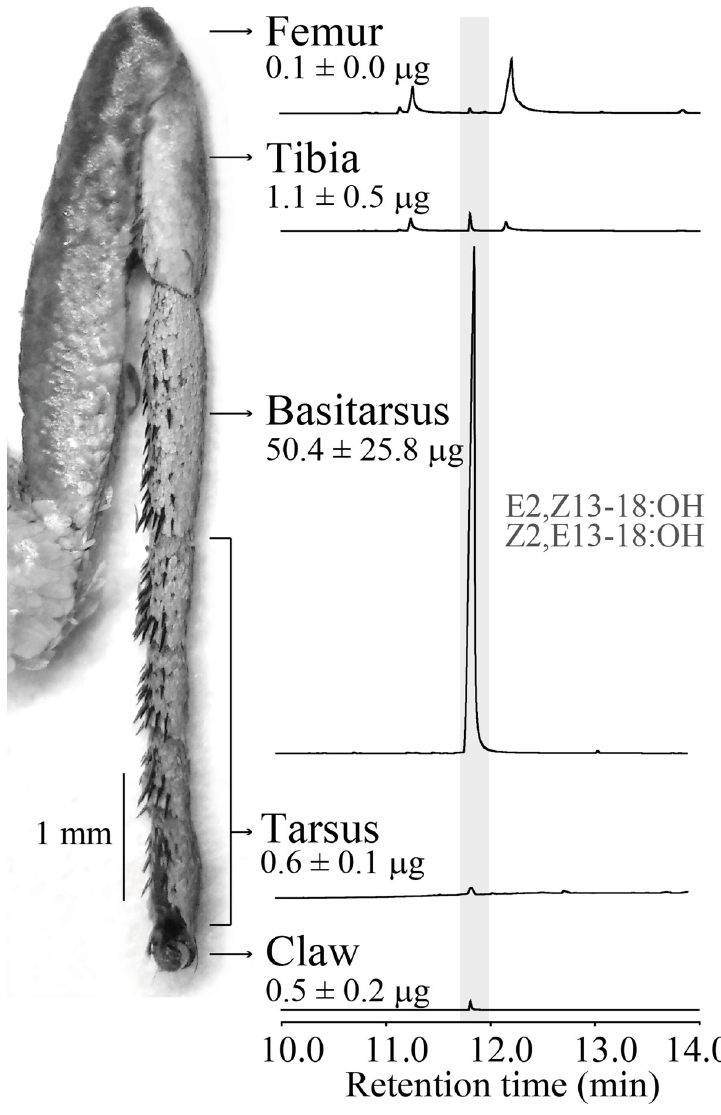
Fig 4. Chromatogram of midleg segments of male Telchin licus . Chromatogram showing the presence of Z2,E13-18: OH and E2,Z13-18:OH (highlighted) and the amount of the diastereoisomer mixture in each midleg segment per male (means ± SEMs). GC-FID equipped with an Rtx-5 capillary column.